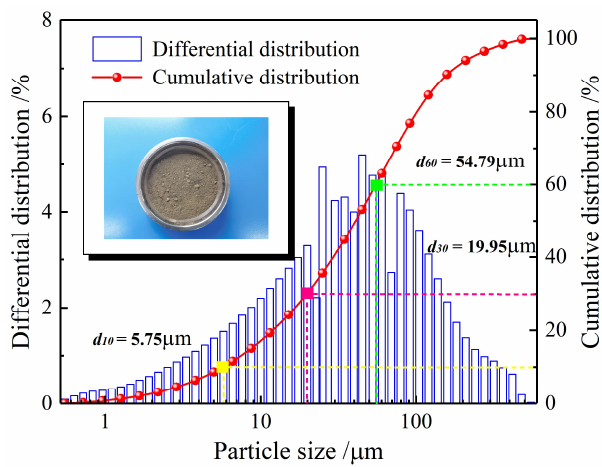
Figure 1. Particle size distribution of tested tailings. Table 1. Chemical composition of tailings.